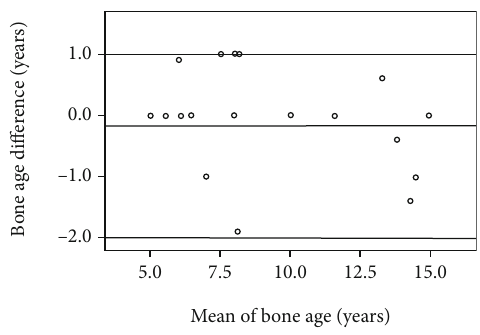
Figure 2: The variation between MRI and radiograph reading for Rater 2 using Bland Altman